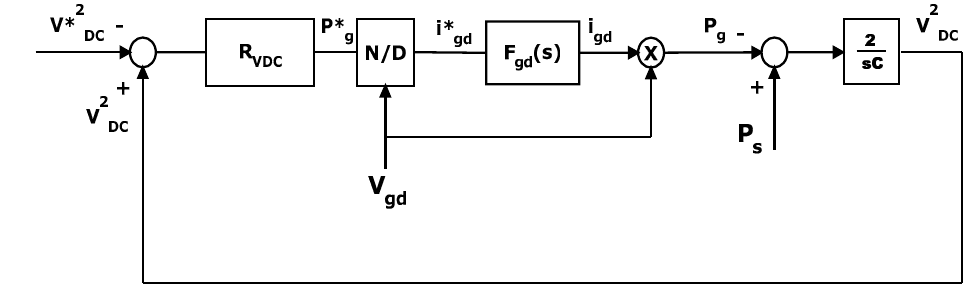
Figure 15. DC voltage control loop.